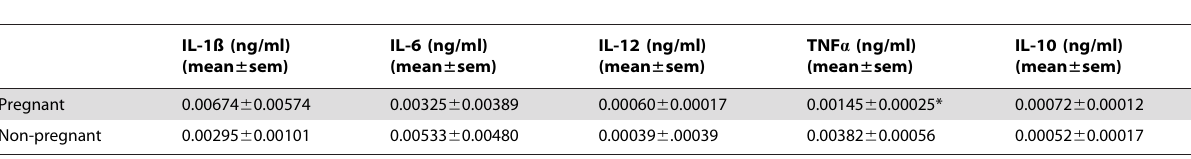
Table 1. Basal levels of cytokines in plasma from pregnant and non-pregnant women.